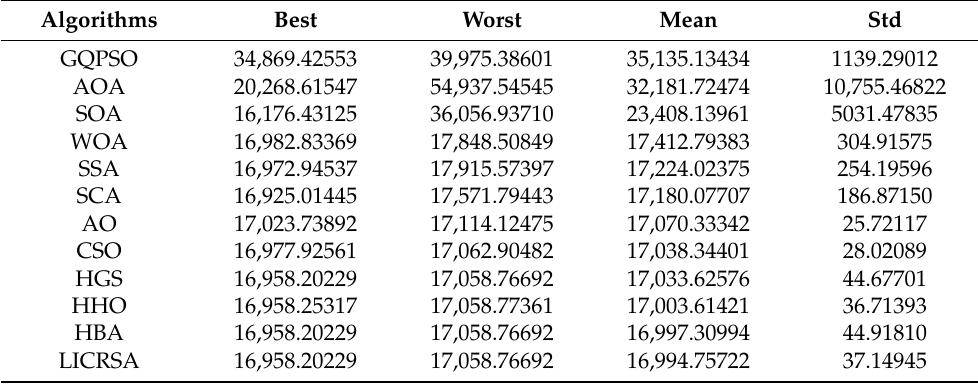
Table 17. Statistics of 20 independent operations of rolling element